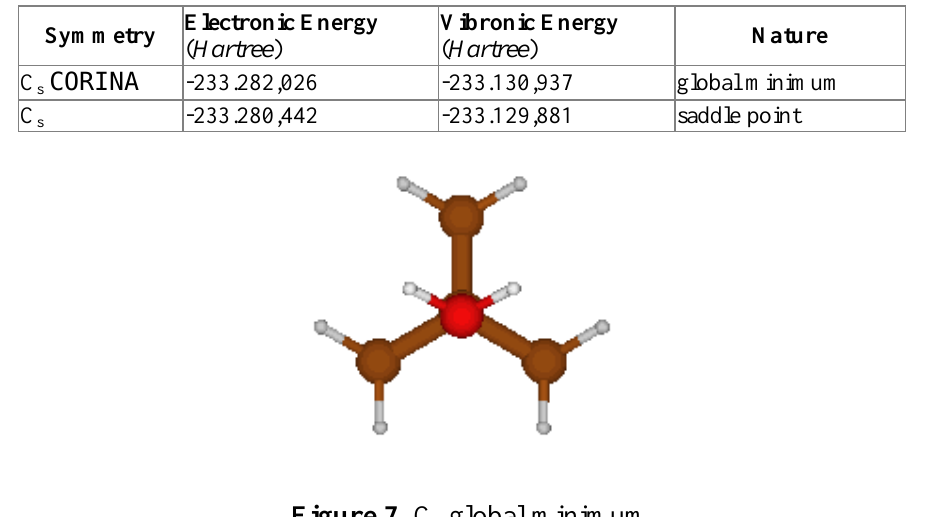
global minimum. s